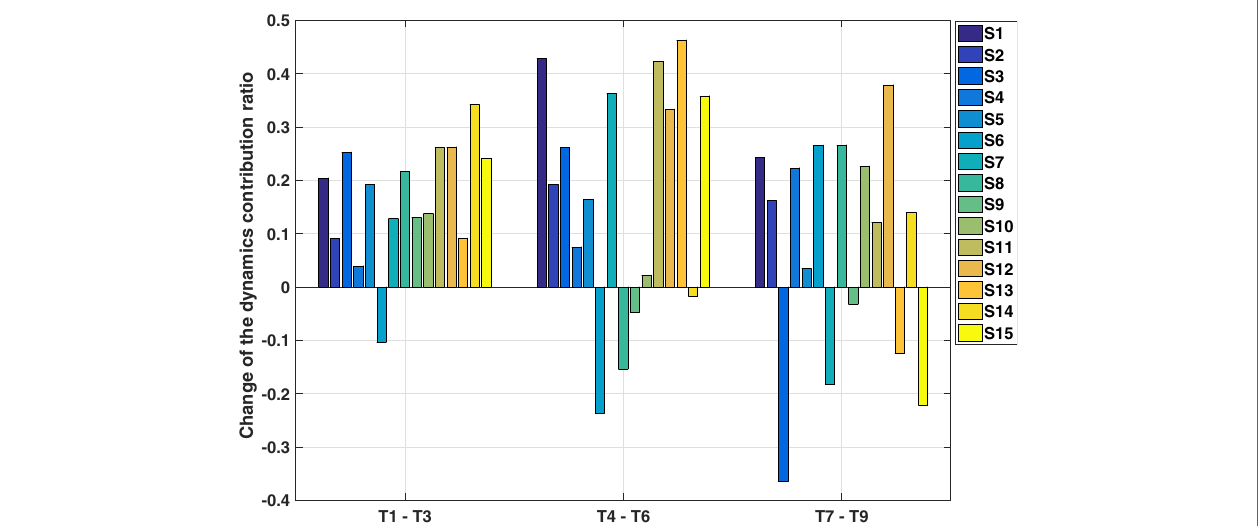
FIGURE 7 | Results of the individual analysis. S1 to S15 represent 15 subjects. The change of the dynamics related cost is derived by subtracting C top from C bot , where C top , C bot are the contribution of dynamics related cost for targets in the top and bottom row, respectively. (e.g., T1–T3 means subtracting the contribution of the dynamics to the target three from to the target one).